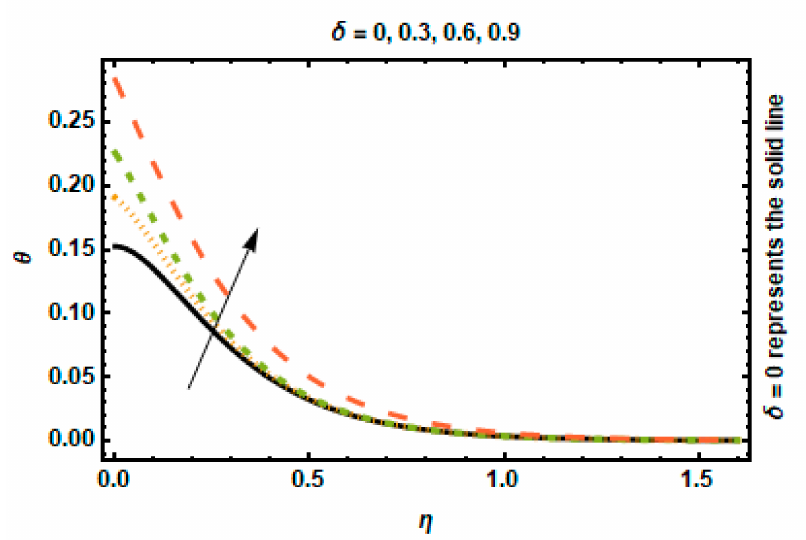
Figure 9. Effects of δ on temperature.